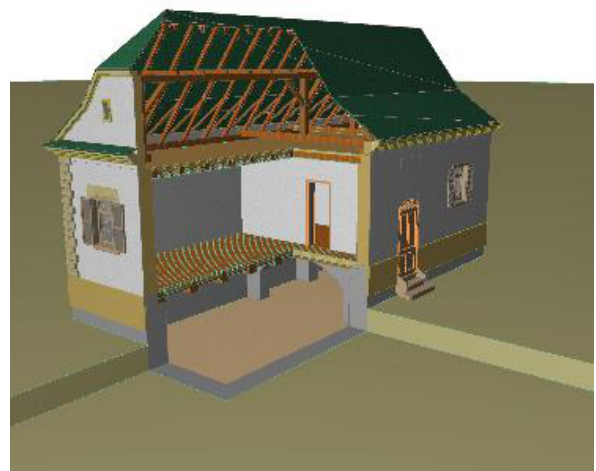
Figure 12. Graphical reconstruction of the residential building of a typical dwelling in the village of